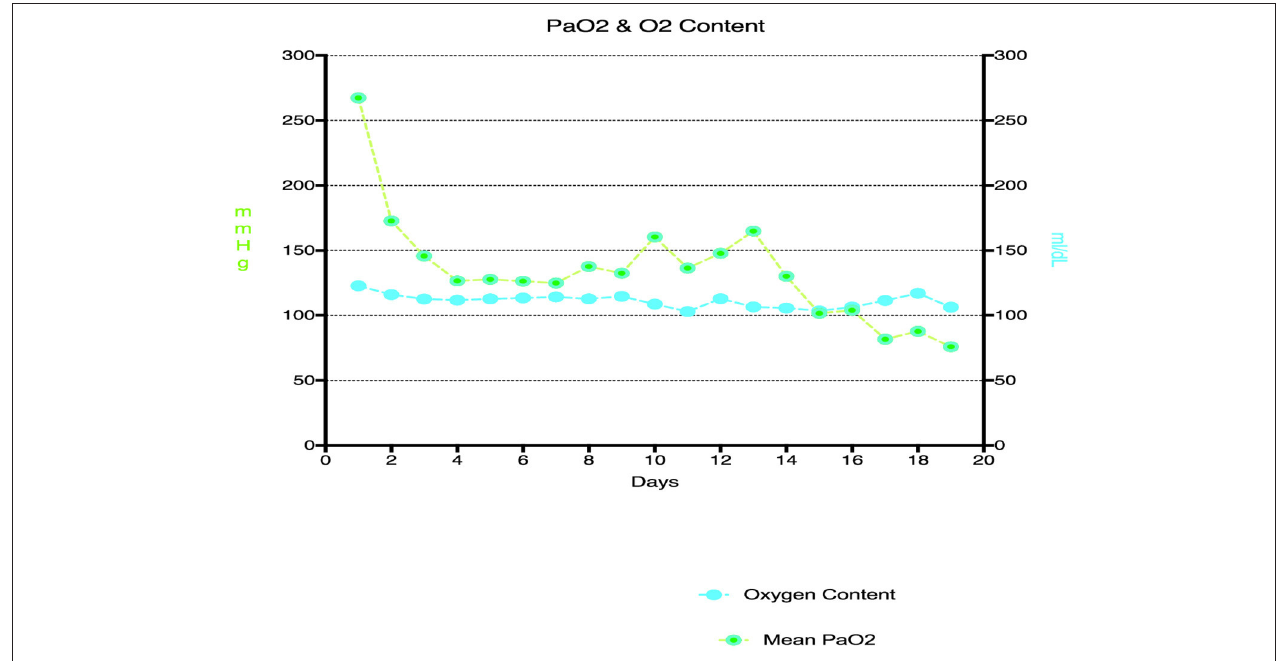
FIGURE 4 | Relationship between PaO 2 and oxygen content for the duration of VA ECMO support.